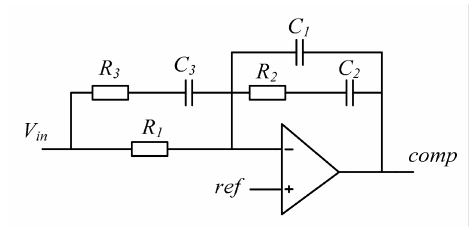
Figure 13. Compensator